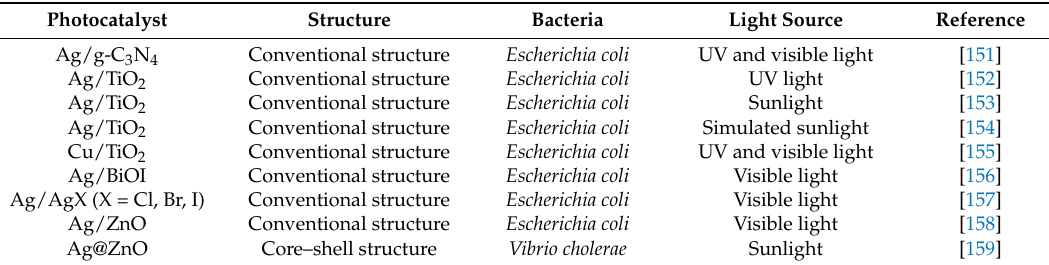
Table 4. M/S nanocomposite photocatalysts for disinfection.